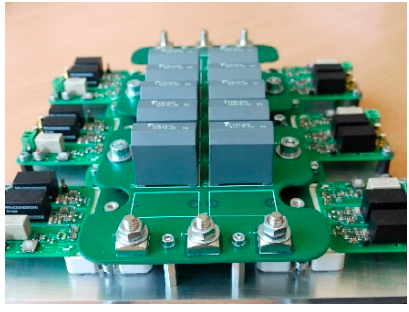
Figure 20. Three-phase inverter developed.